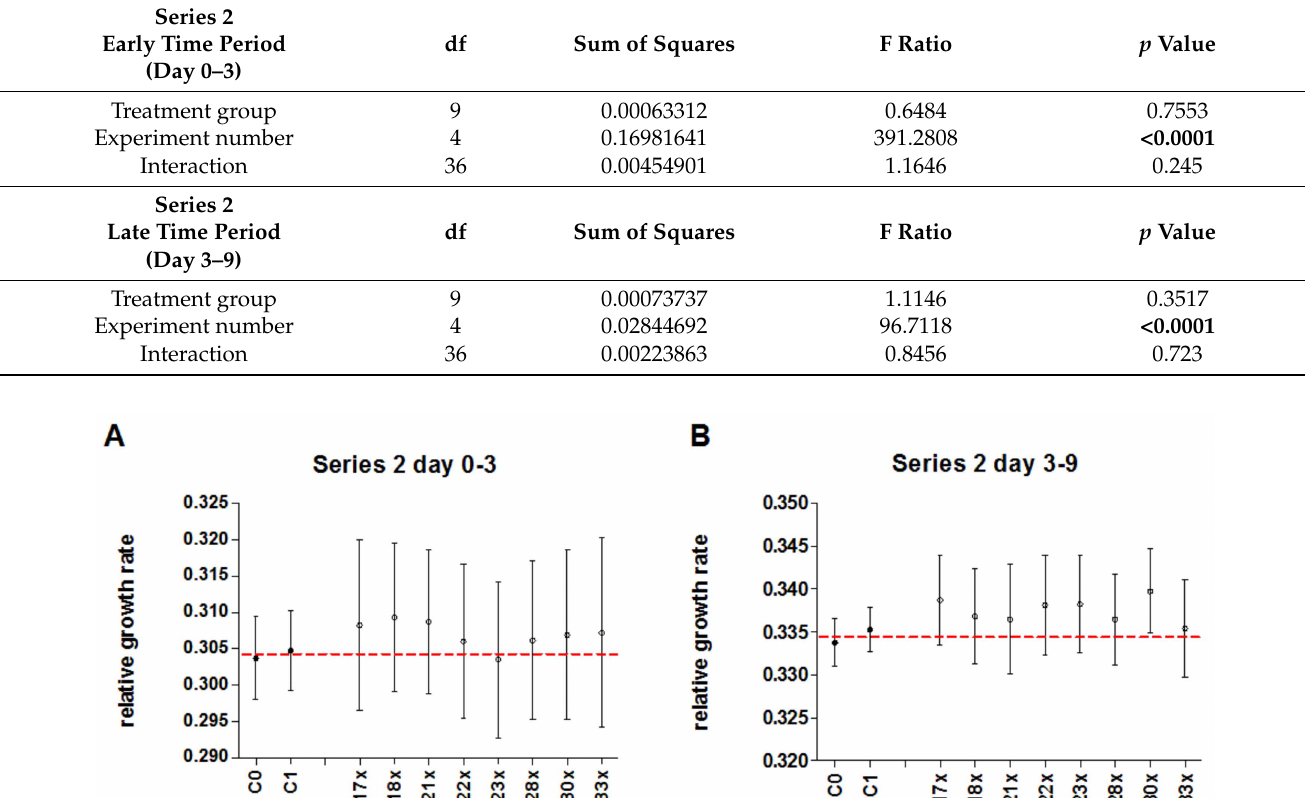
Figure 7. Mean relative growth rate ( ± 95% CI) of duckweed treated with either potentised As 2 O 3 (potency levels 17x–18x, 21x–23x, 28x, 30x, 33x, numerically pooled, n = 200) or water as control (unsuccussed and succussed water samples, numerically pooled, n = 170) in the 5 independent experiments of series 2. ( A ) Early time period (day 0–3), ( B ) Late time period (day 3–9), * p < 0.05. Table 6. Statistical analysis of experimental series 2. Results of a two-way ANOVA of series 2 for single treatment (As 2 O 3 17x–18x, 21x–23x, 28x, 30x, and 33x) and control (unsuccussed and succussed water) groups, analysed over n = 5 experiments in early (day 0–3) and late time period (day 3–9). df—degree of freedom. Significant values are printed bold.